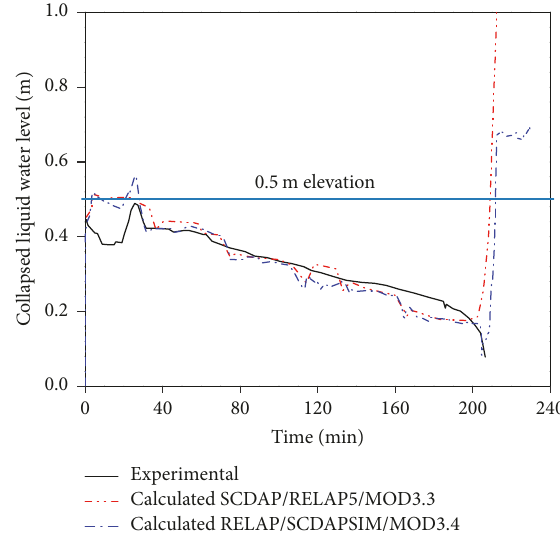
Figure 6: Comparison of experimental and calculated water levels in the